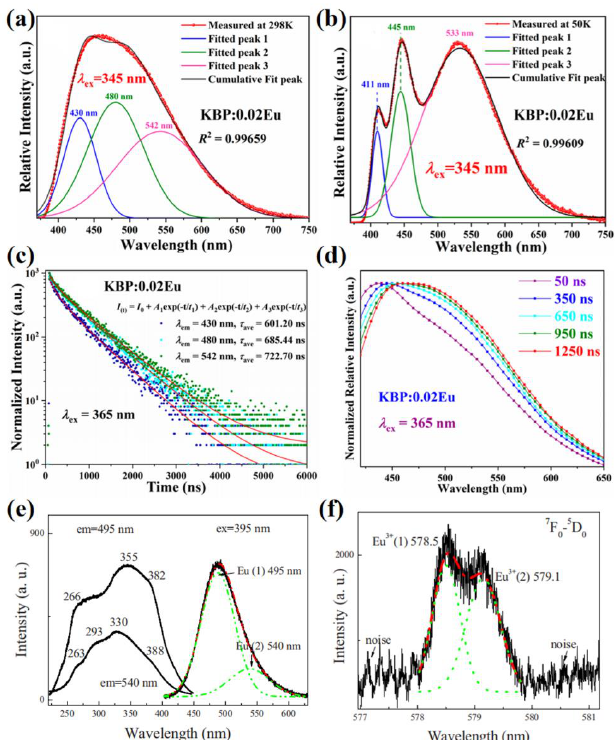
Figure 10. Fitted Gaussian components of the ( a ) emission spectrum at 298 K, ( b ) emission spectrum at 50 K, ( c ) comparison of the different emission decay curves with identical excitation (430, 480 and 542 nm), ( d ) normalized spectral slices of TRPL at 50, 350, 650, 950 and 1250 ns of the KBa 2 (PO 3 ) 5 :0.02Eu. Reprinted with permission from ref. [39]. Copyright 2020 American Chemical Society. ( e ) The emission and excitation spectra of KCaPO 4 :Eu 2+ . ( f ) The excitation spectra in the region of 7 F 0 → 5 D 0 transition in KCaPO 4 :Eu 2+ . Reprinted with permission from ref. [88]. Copyright 2010 Electrochemical Society (Pennington, NJ, USA).